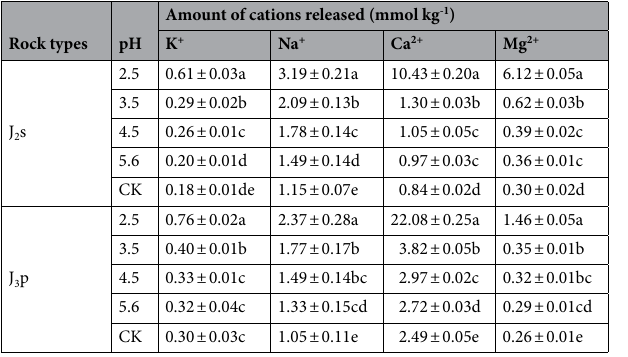
Table 3. Amounts of cations released from purple rock under various pH weathering conditions. Different letters in a column indicate significant differences between the treatments, where P <